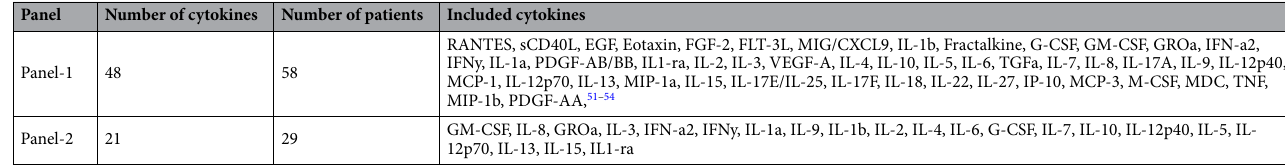
Table 2. Cytokines contained in each panel.